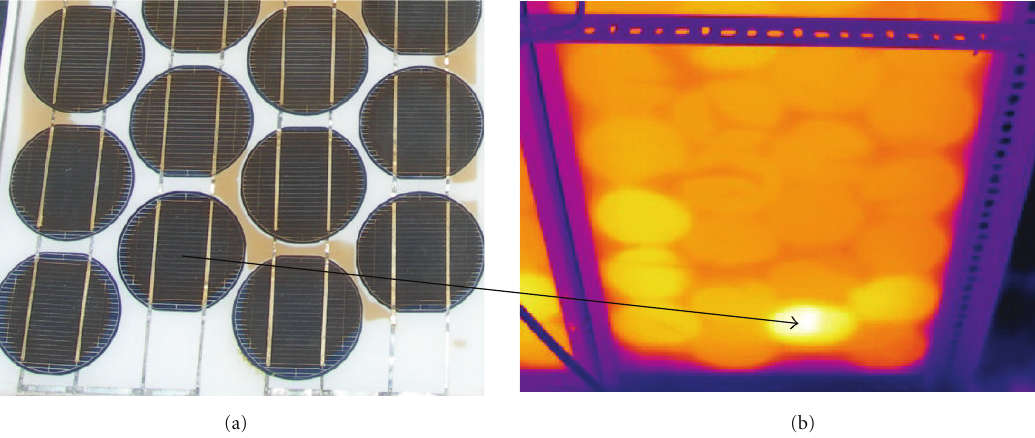
Figure 9: (a) Digital image of the lower part of a BP B 1233 c-Si PV panel; (b) IR image of the back of the panel revealing a hot cell in reverse order as illustrated by the